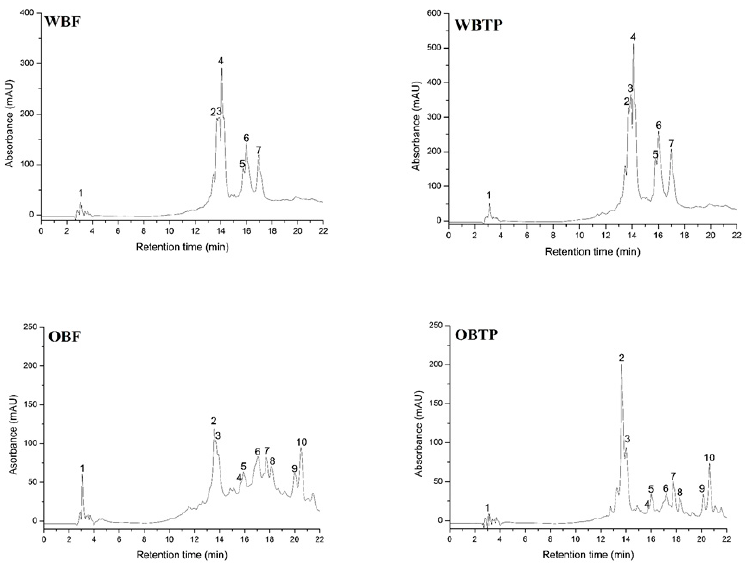
Figure 3. HPLC chromatograms of WBF, WBTP, OBF, and OBTP.